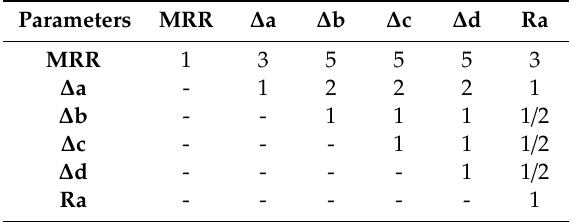
Table 3. Hierarchical structure of the pairwise criteria